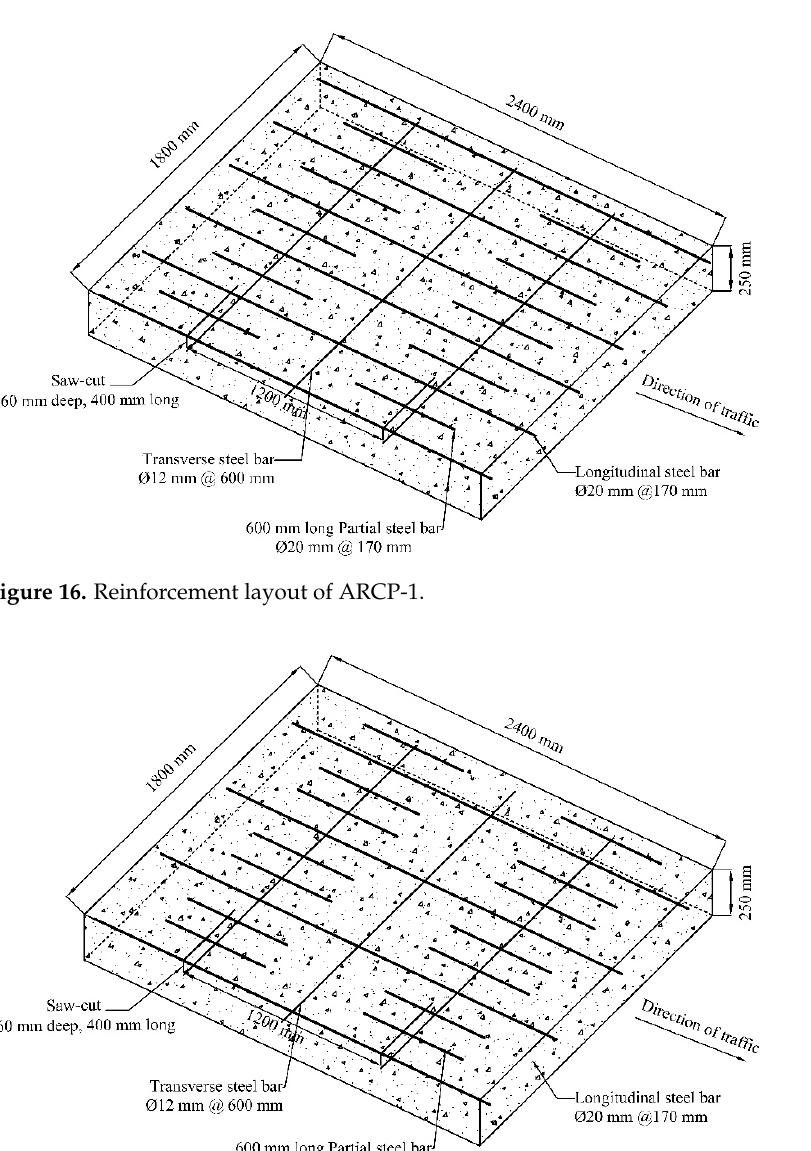
Figure 15. Demonstration of reinforcement layout of ARCP.